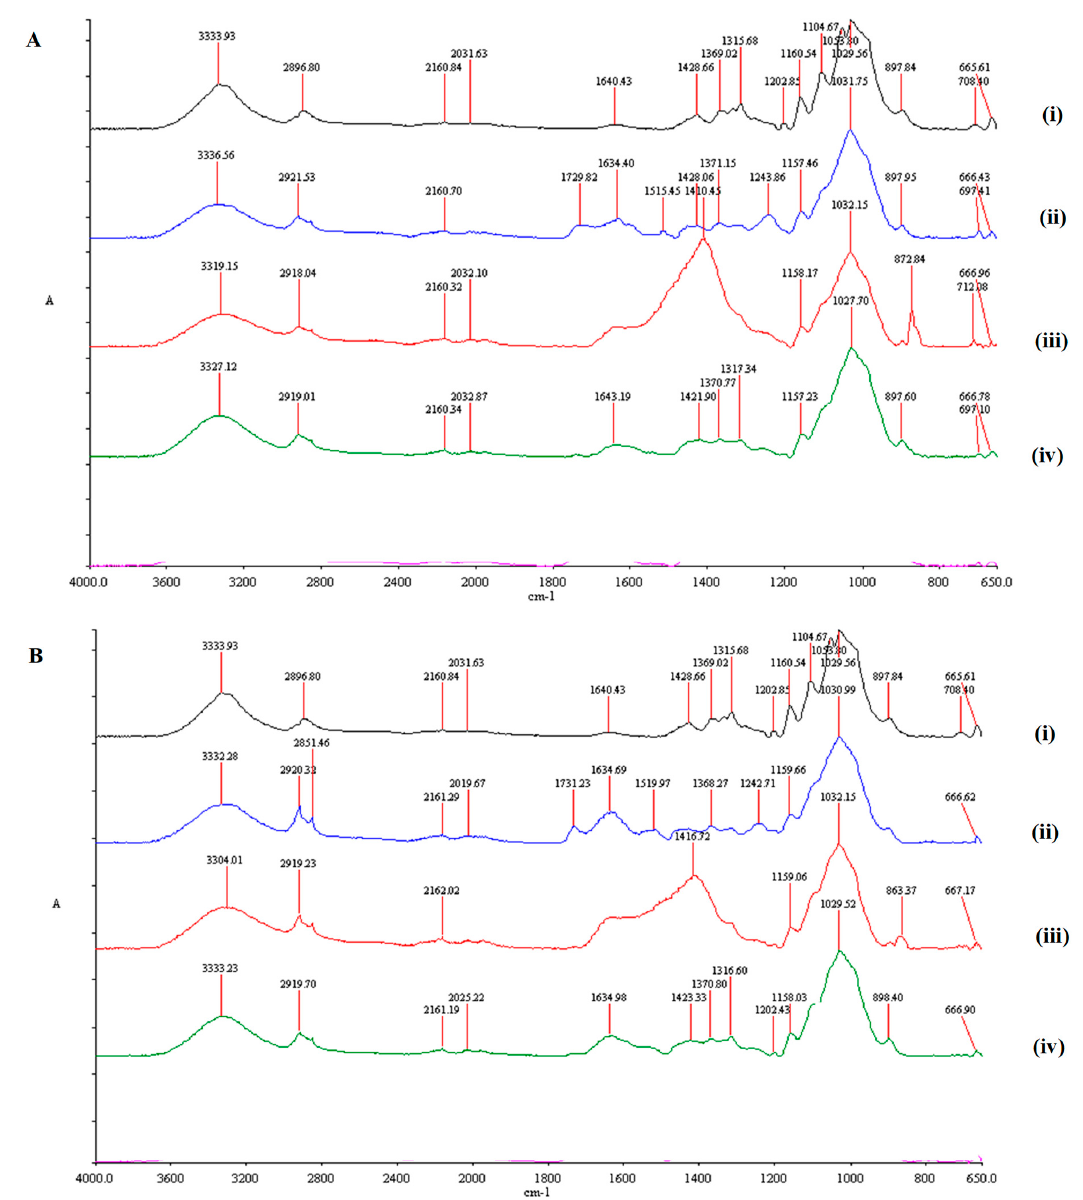
Figure 2. Comparative FTIR in the spectra range 4000–650 cm − 1 corresponding to Avicel PH101 (i), untreated (ii), Ca(OH) 2 pretreated (iii) or sodium hydroxide pretreated biomass. ( A ) represents the SSB biomass and ( B ) represents the corncob biomass. Keys: ( A ) in the y -axis represents arbitrary units.